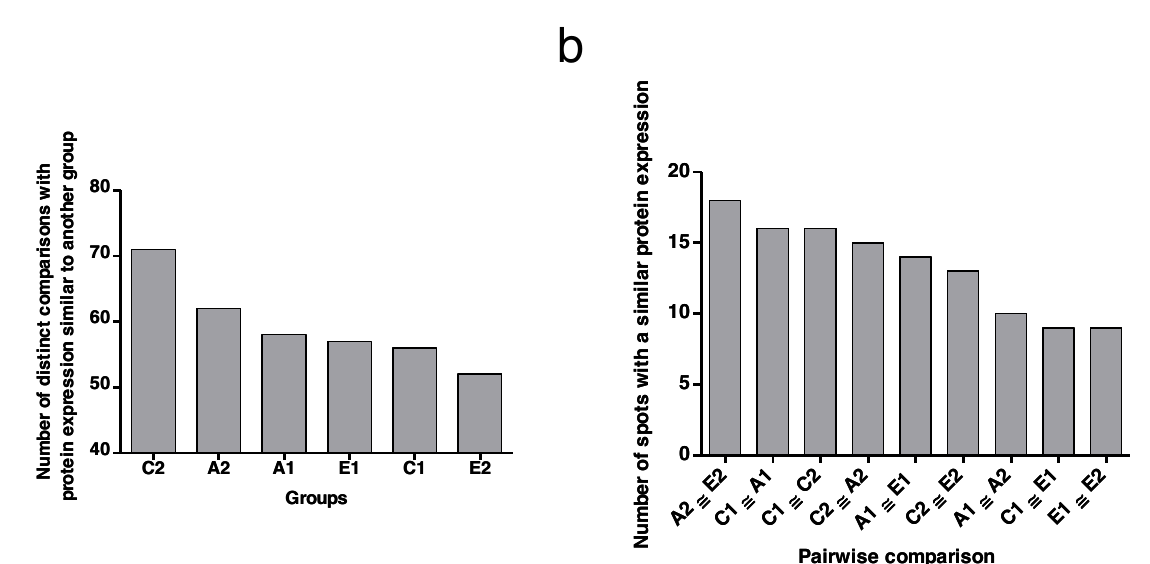
Figure 2. Pairwise comparisons of protein spots. a , Pairwise comparison for all the possible pairs of group samples in one spot performed for all the spots (135 total comparisons per group). The number of times where the relative expres - sion value of each group was considered to be similar to another (ratio≤|2|) is reported. Asymptomatic (C1, A1, E1) and black streaked (C2, A2, E2) trunk wood of control (C1, C2), apoplectic (A1, A2) and esca proper affected (E1, E2) plants. b , Pairwise comparison involving samples from asymptomatic (C1, A1, E1) and black streaked (C2, A2, E2) trunk wood performed for all the spots (27 total comparisons per group). The number of times (spots) where their relative expression was considered to be similar (ratio≤|2|)) is